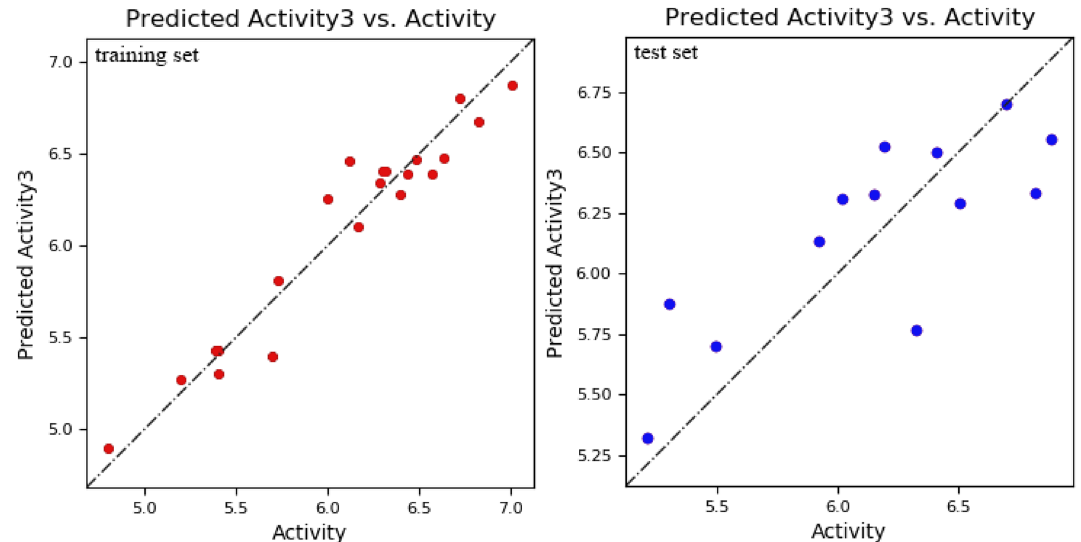
Figure 2. The scatter plots of actual vs predicted pIC50 values of the structures employed for 3D QSAR model development. On the left is the scatter plot for the training set structures and on the right is the scatter plot for test set structures.